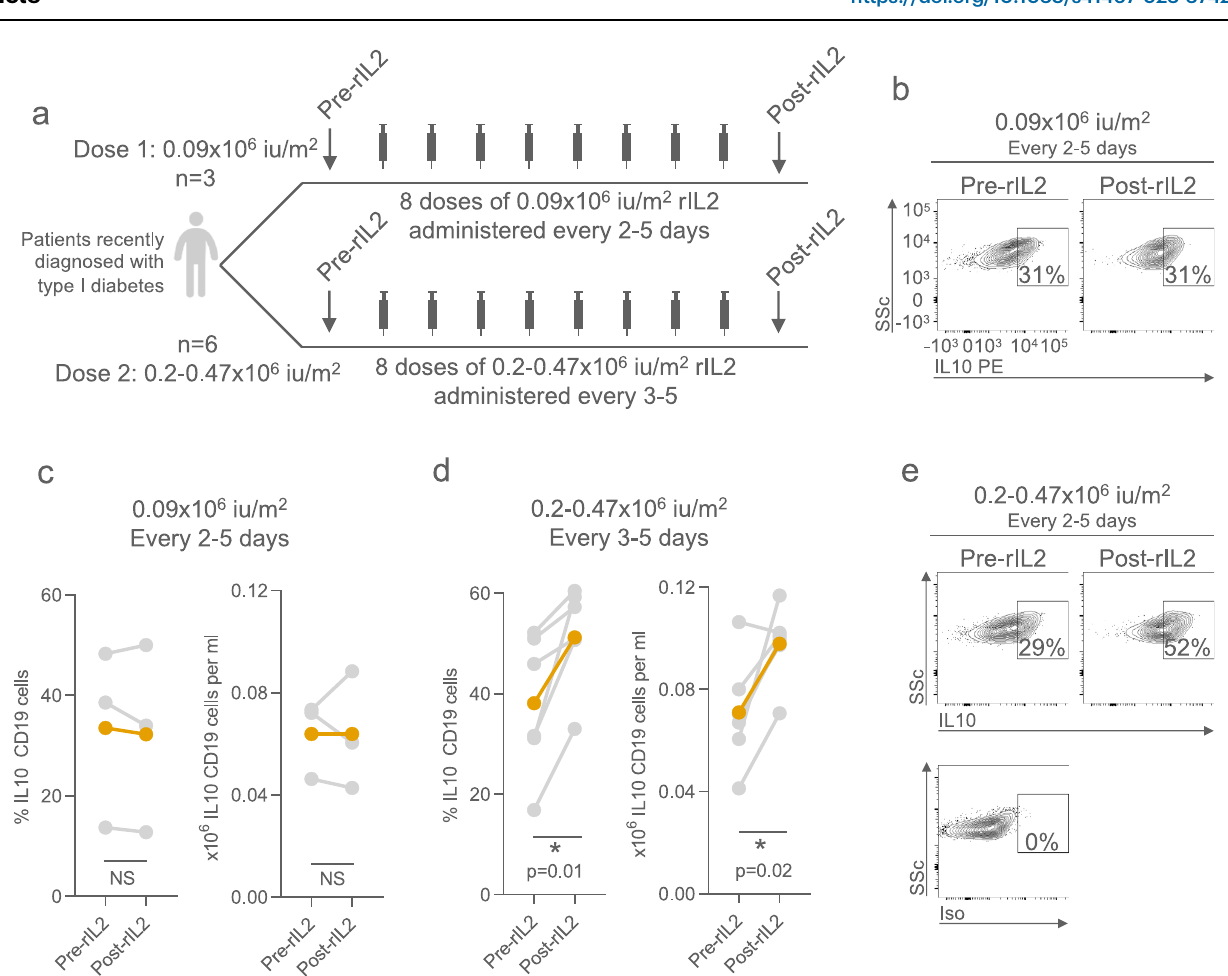
0.2 – 0.47×10 6 IU/m 2 ( d ) aldesleukin. Coloured line indicates mean changes fol- lowing treatment. Representative fl ow cytometry plot of IL-10 expressing B cells pre- and post- 0.09×10 6 IU/m 2 ( b ) or 0.2 – 0.47×10 6 IU/m 2 ( e ) aldesleukin. p -values generated using a paired two-tailed parametric t-test. * p <0.05, ** p <0.01, *** p <0.001. Source data are provided as a Source Data fi